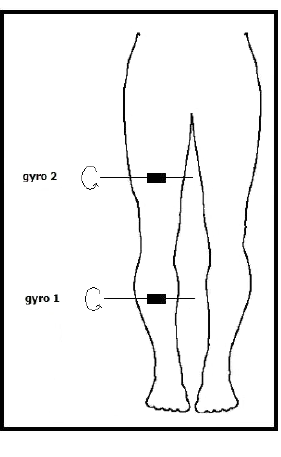
Figure 3. Position of the two gyroscopes on the human leg (body figure adopted from http://www.answers.com/body breadths).